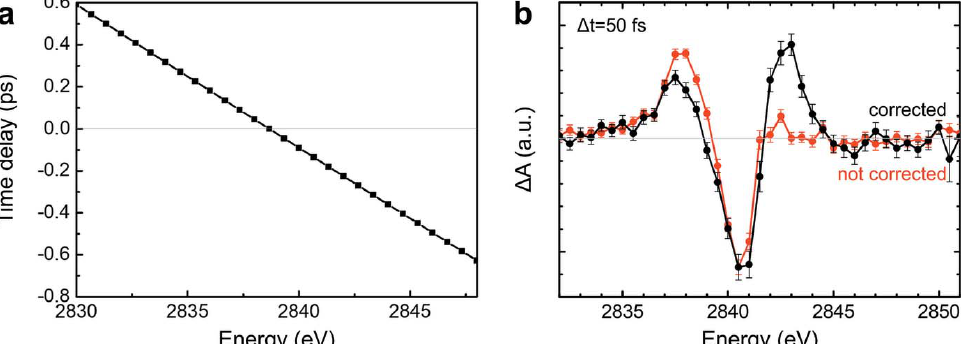
Figure 5 ( a ) Time delay difference as a function of incident X-ray energy at 2.84 keV. ( b ) Transient XAS spectrum of tris(bipyridine) ruthenium(II) chloride ([Ru(bpy) 3 ] 2+ ) at a time delay of 50 fs before and after correcting for the X-ray arrival time through the double-crystal